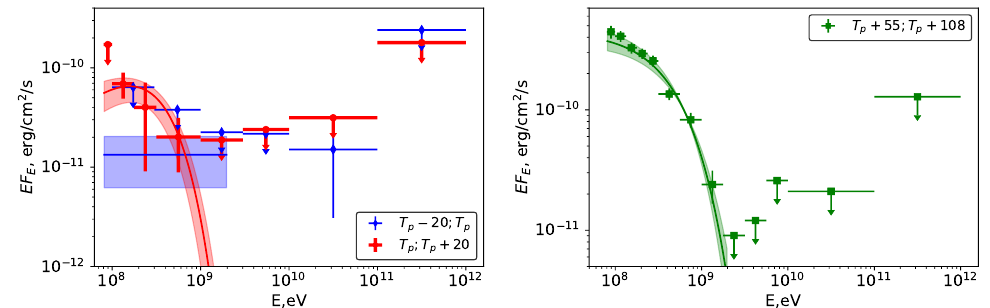
Figure 3. ( Left ) Fermi/LAT spectra of PSR B1259-63 as seen at ( − 20–0) days before the periastron 2021 (blue points) and (0–+20) days after the periastron 2021 (red points). Shaded regions of the corresponding color illustrate 1 σ confidence range for the fitted models. ( Right ) Fermi/LAT spectrum of the period characterized by the highest flux in >0.1 GeV band during 2021 periastron passage (+55–+108 days after the periastron), see Table 1 for the best-fit parameters’